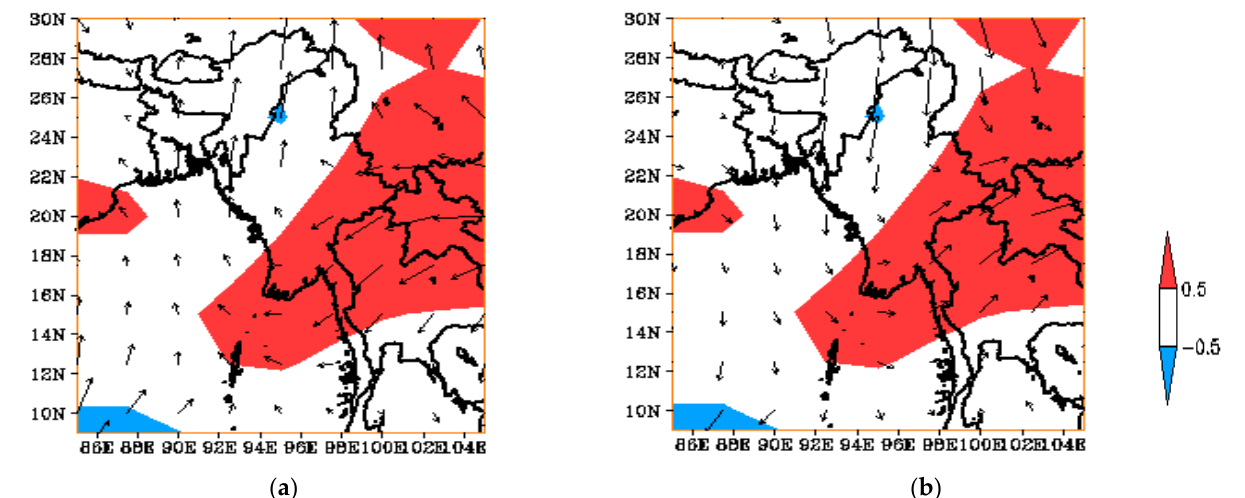
Figure 7. Summer (March ‒ April) wind anomaly at 850 hPa for ( a ) warm years and ( b ) cold years over Myanmar. Figure S3 elucidates the difference between warm and cold years in terms of the summer SST anomaly, which tends to be drier in the eastern and central Pacific due to the El Niño pattern related to Myanmar’s summer. The difference between warm and cold years in terms of the summer relative humidity (RH) indicates a negative anomaly in the whole region. It is clear that temperature significantly decreases more than RH over the country (Figure 8). Figure 9a shows the dominant modes of variability of the rainy season (May–October) air temperature over Myanmar. The first EOF-1 exhibits 62% of the total variance, a dipole mode pattern of variability with warming in the central warm zone and coldness in the southern and northern regions (Figure 12a). The second EOF-2 spatial pattern explains 25% of the total variance, a dipole mode variability, with warm conditions along the coast and in the northwestern (China State) and eastern (Shan State) regions, whereas increasingly cold weather could be seen in northern, central, and northern Shan State (Figure 9b and Figure S5). It is also anticipated that the spatiotemporal variability of temperature and related extremes will intensify in the near future [39,42]. To some extent, these challenges were associated with large-scale anomalous atmospheric circulation patterns, and the resultant flux resulted in local and remote damage on a vast scale [3,13]. Figure 9a indicates that a rainy season wind anomaly at 850 hPa for cold years leads to westerlies and south westerlies in the region. During cold years, easterlies and northeast winds are dominant in the core regions of the country (Figure 9b). Both warm/cold years appeared to have a positive wind anomaly in southern and northeast regions, with strong westerly winds in warm years; however, a strong easterly wind anomaly was observed during cold years.